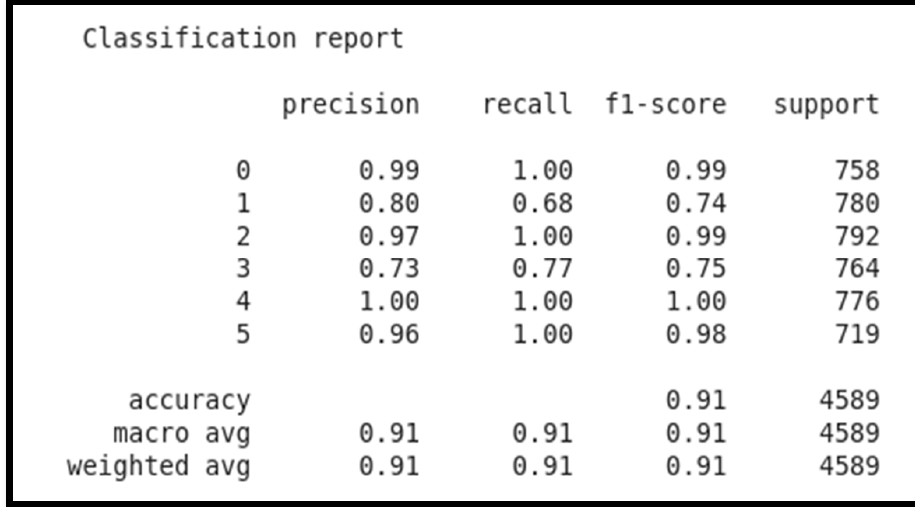
Figure 20. Classification report of random forest.